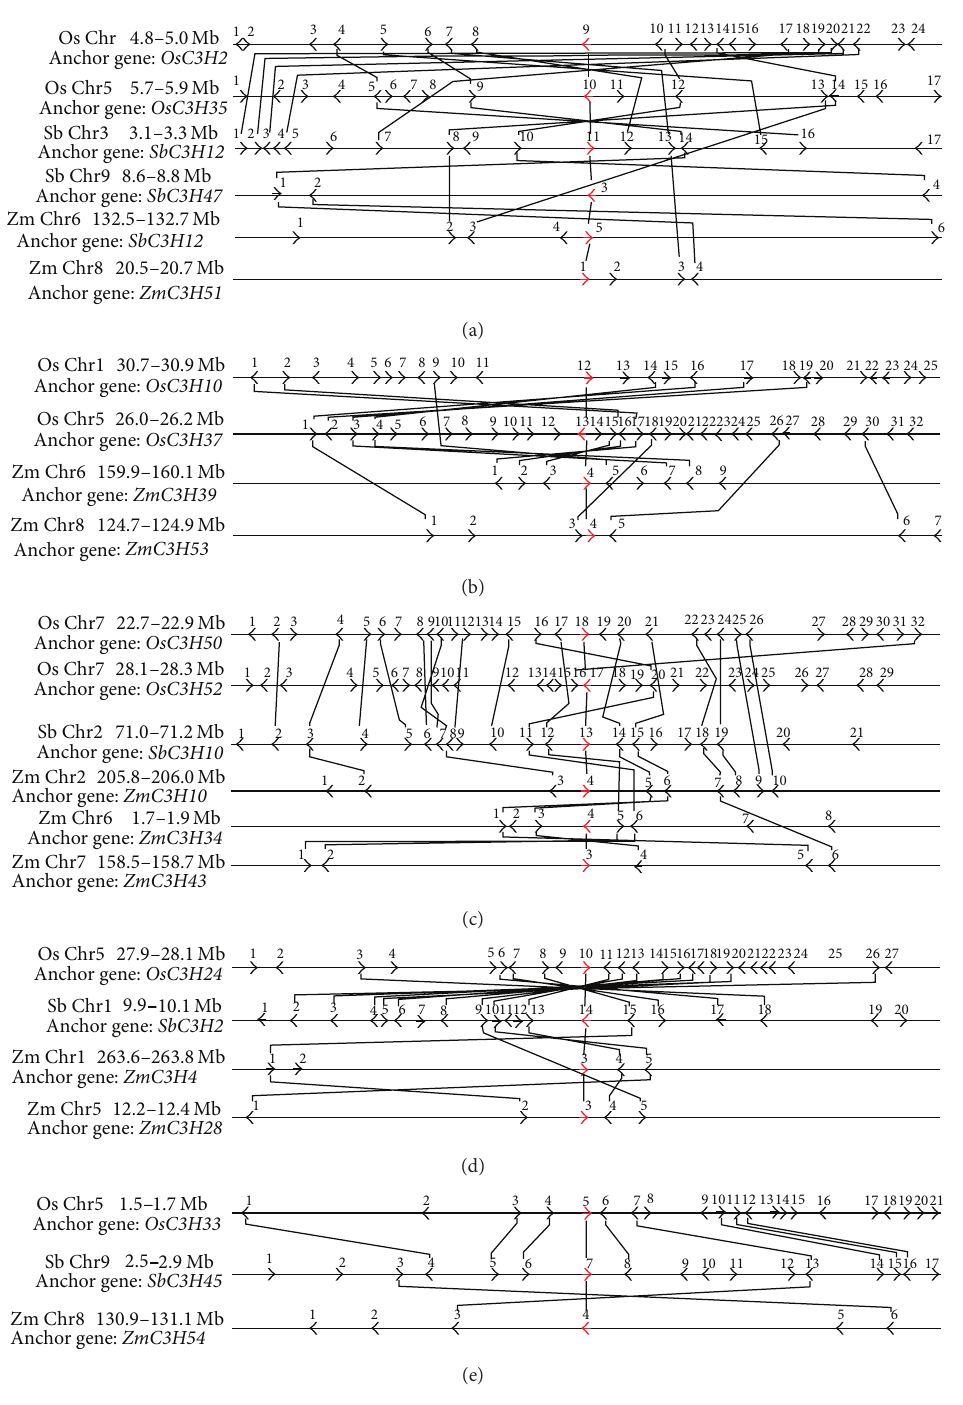
Figure 5: Microsynteny maps of CCCH IX genes in grasses. Red arrows represent anchor (CCCH IX) genes, and upstream and downstream genes are represented by black arrows. All genes are numbered from left to right for each segment. Black lines connect conserved gene pairs.